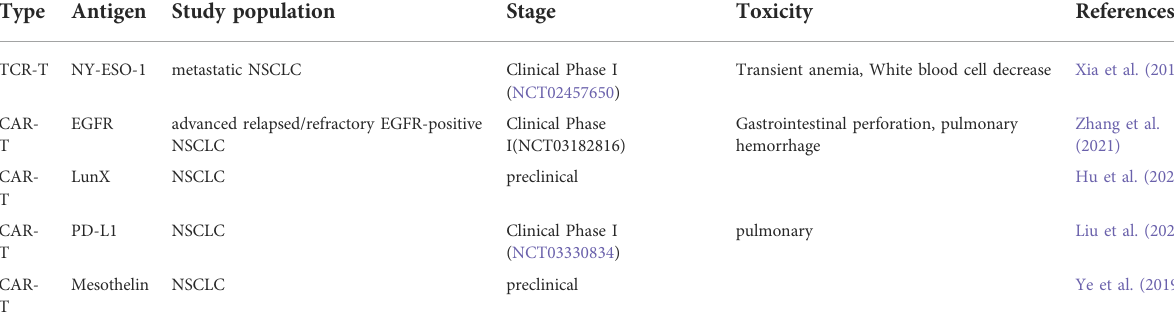
TABLE 2 Clinical trials of cell therapy for